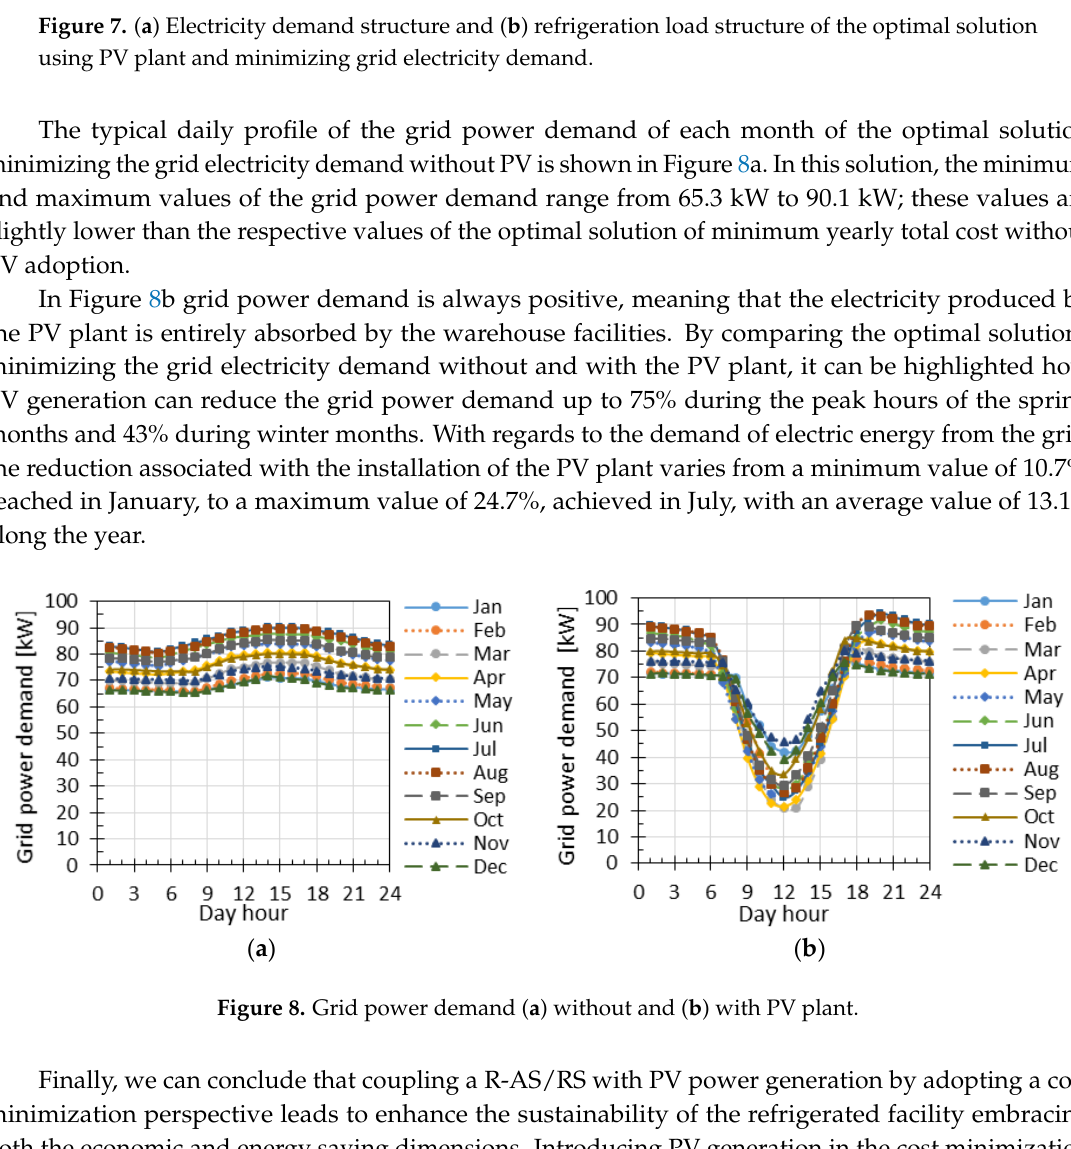
Figure 7. ( a ) Electricity demand structure and ( b ) refrigeration load structure of the optimal solution using PV plant and minimizing grid electricity demand.